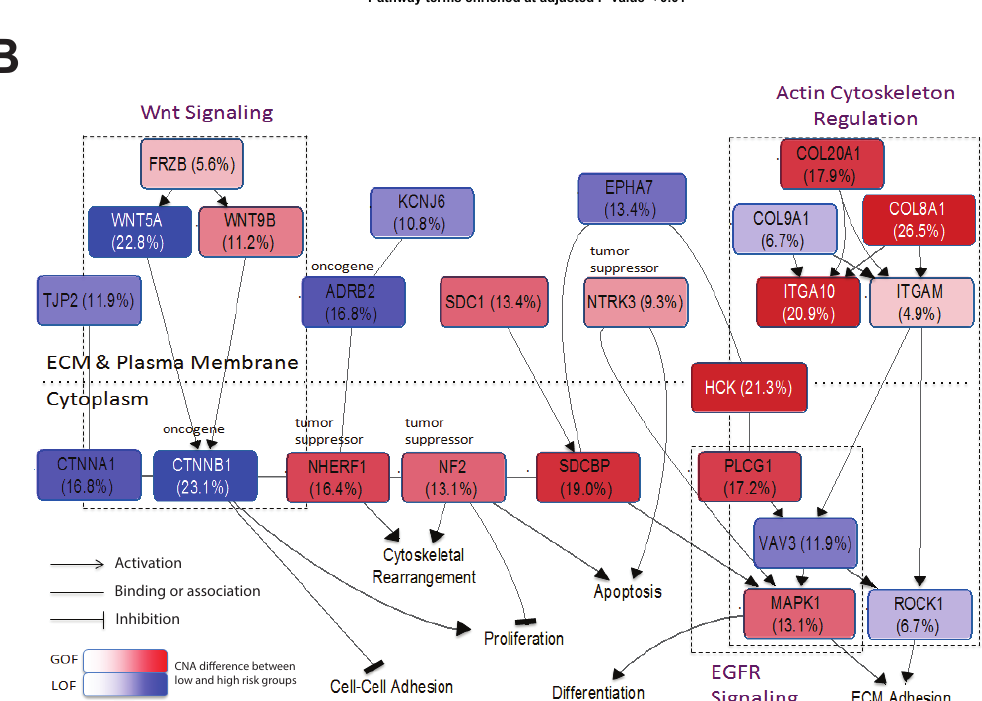
Figure 4. Enriched pathways and biological processes for genes in NAG. ( A ) Pathways in Pathway Commons and Gene Ontology were enriched for NAG genes. Bar plots show the proportions of NAG genes within each pathway that were classified as gain of function (GOF) or loss of function (LOF) alterations in TCGA cases. ( B ) A diagram of enriched pathways identified from NAG and their associated expression signature genes. The main pathways that emerged included Wnt signaling, integrin signaling and actin cytoskeleton regulation. Blue nodes identify copy number loss or inactivating mutation indicating loss of function (LOF), and red nodes indicate copy number gain indicating gain of function (GOF). Percentages in brackets represent the di ff erence in alteration frequency between patients of low and high mortality risk, respectively, as classified by the NAG and the NAG expression score for TCGA NSCLC tumors. The color intensity reflects the proportion of tumors with the gene alteration. ECM = extracellular